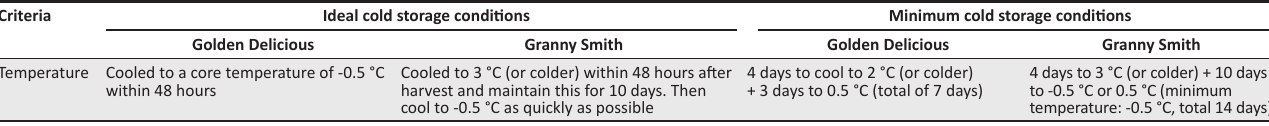
TABLE 1: Perishable products export control board ideal and minimum cold storage conditions for Golden Delicious and Granny Smith. Criteria Ideal cold storage conditions Minimum cold storage conditions Golden Delicious Granny Smith Golden Delicious Granny